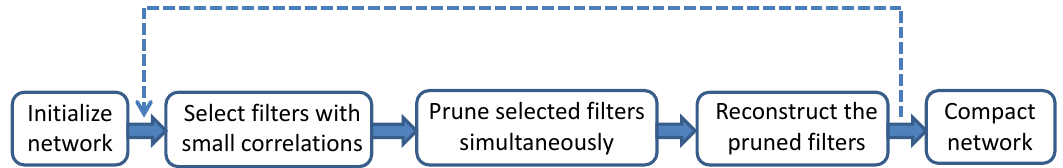
Figure 3. The flowchart of the proposed filter pruning. The dotted line means the iterative training scheme.